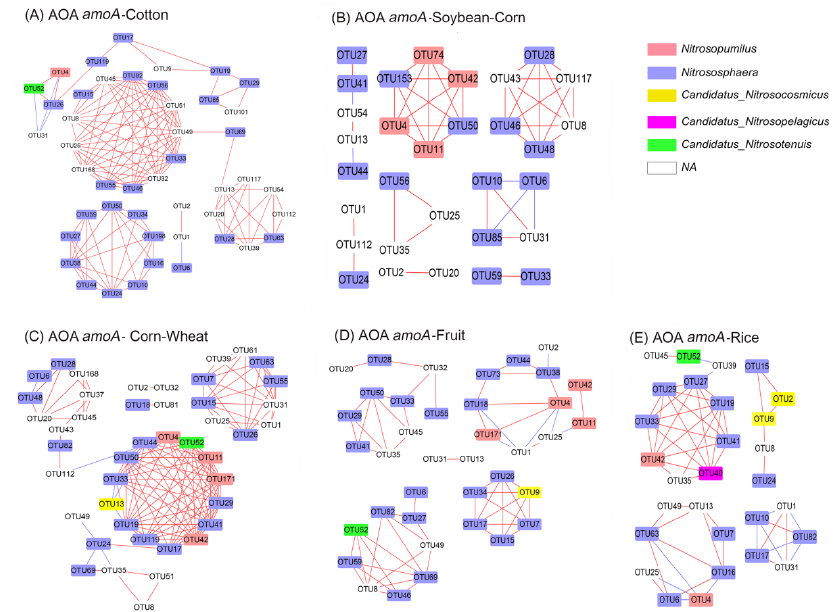
Microorganisms 2019 , 7 , x FOR PEER REVIEW 18 of 25 Figure 7. Network analysis of amoA – AOA OTUs in the five ecosystems: ( A ) Cotton; ( B ) Soybean – Corn; ( C ) Wheat – Corn rotation; ( D ) Fruit; ( E ) Rice. The network shows only the “dominant” OTUs with a relative abundance >0.5% in at least one replicate. Red solid lines: significantly positive relationships (Pearson correlation r > 0.85); blue solid line: significantly negative relationships (Pearson correlation r < −0.85).